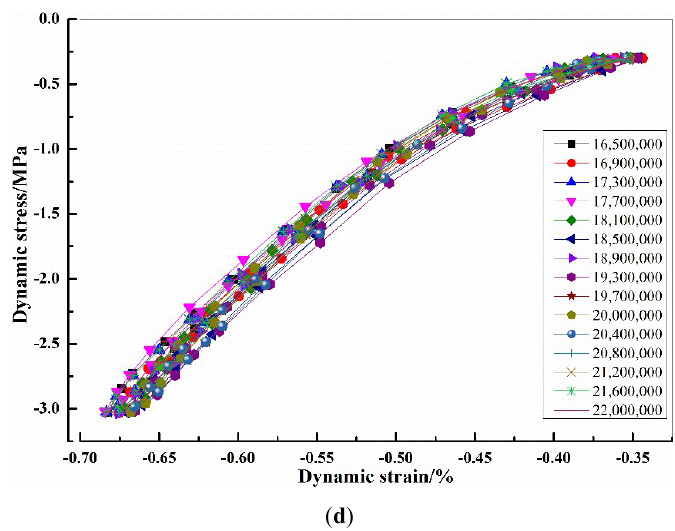
Figure 4. Dynamic stress–strain hysteresis curves of structural EPS concrete: ( a ) 0–2,500,000 times; ( b ) 2,500,000–3,500,000 times; ( c ) 3,500,000–16,350,000 times; ( d ) 16,350,000–22,000,000 times.